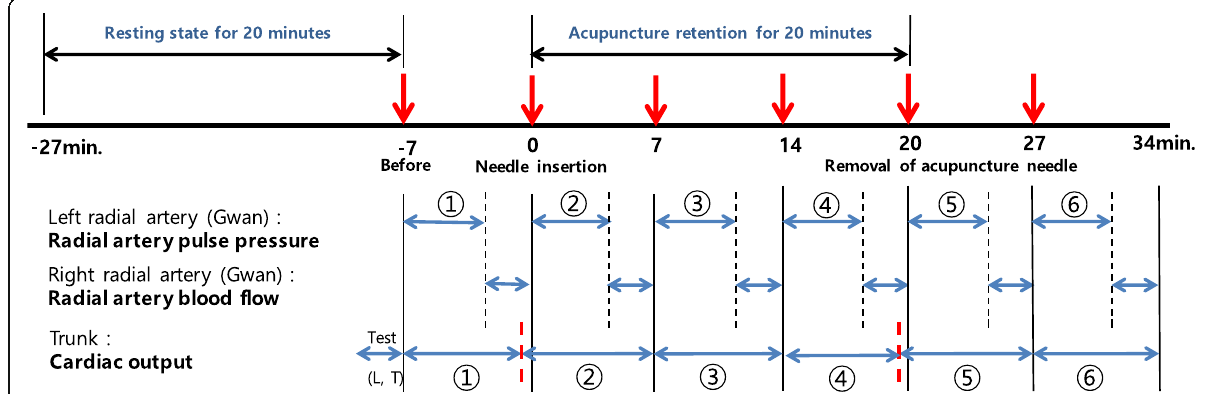
Fig. 1 Study procedure for the assessment of hemodynamic and RPPW variables at the following points: pre-acupuncture, immediately after needle insertion, during needle insertion, and removal of